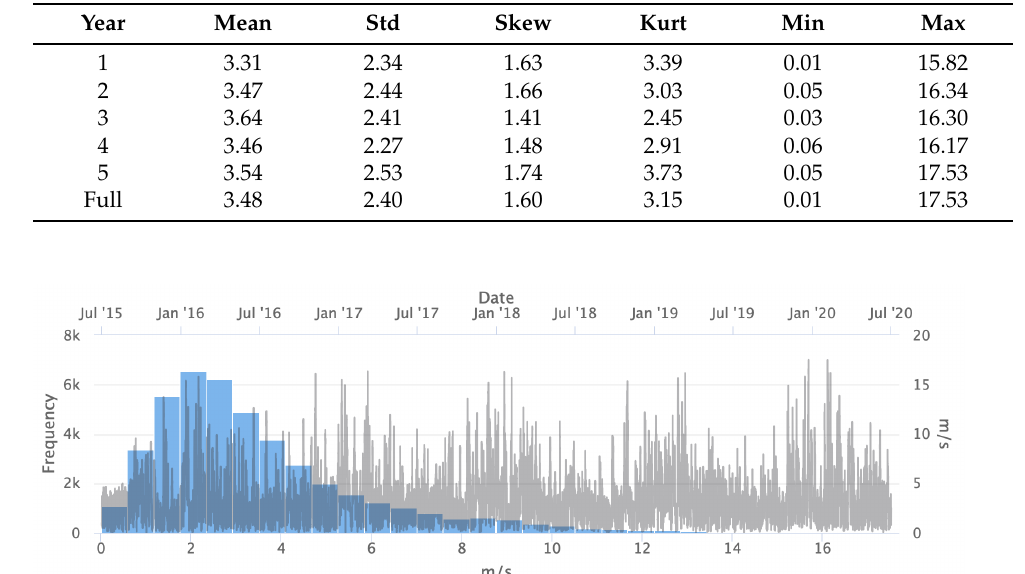
Table 1. Wind speed statistics for the location 42 ◦ N and 13.75 ◦ E (Central Italy). Speed in m/s.